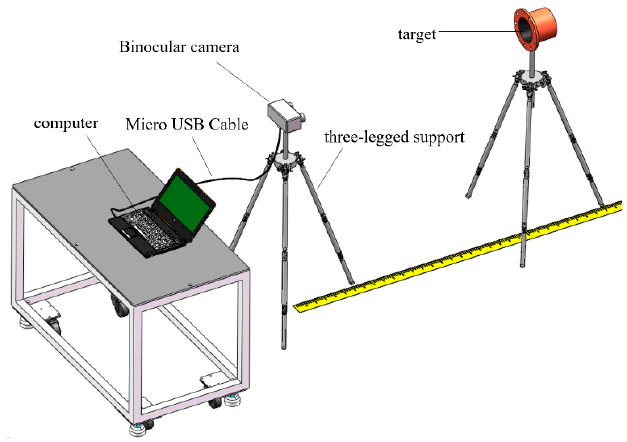
Figure 10. Schematic diagram of the experiment. Table 3. Comparison of the results.